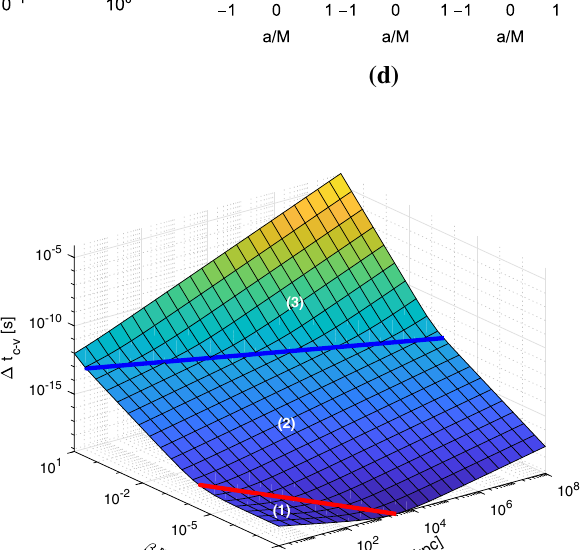
Fig. 3 The time delay (53) for the KN spacetime as a function of β ( a logarithmically and b linearly), a ( c logarithmically and d linearly). The “1st, 2nd” and “3rd” stand for corresponding terms of Eq. (53). In plot c , the 3rd term depends on β very weakly and therefore the solid curves overlap for different β . In plot d , the 3rd term dominates (cid:2) t when β is small and therefore the “+” lines slightly overlap the solid (cid:2) t lines